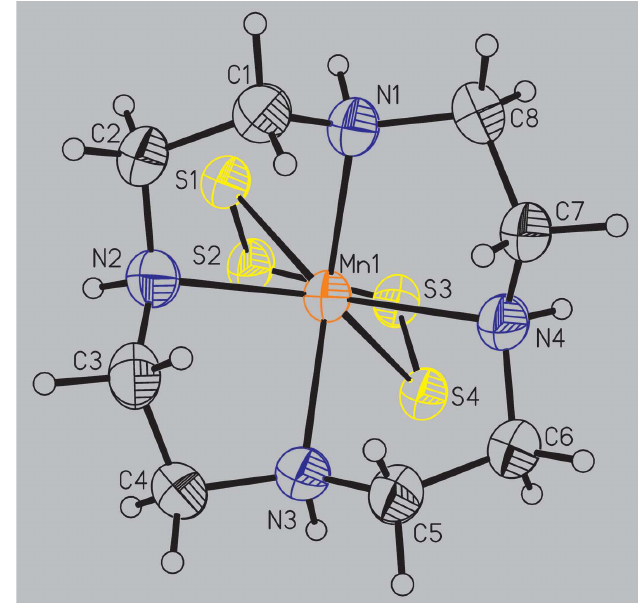
Figure 1 Experimental and calculated XRPD powder patterns of the title compound. The reflections of side products are marked by stars.